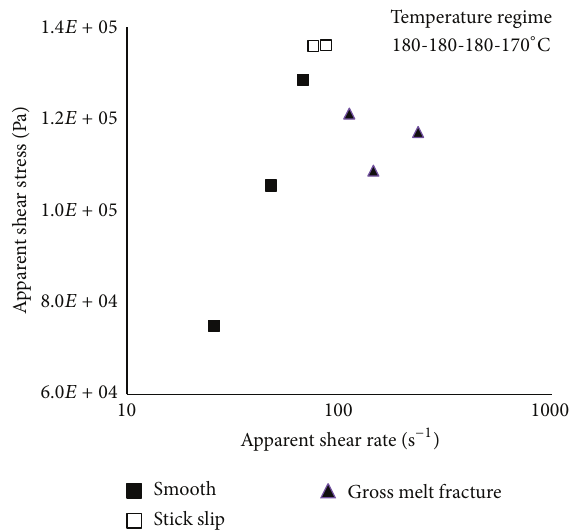
Figure 7: Flow curve of HDPE with and without additives at temperature 170 ∘ C in a MiniLab.